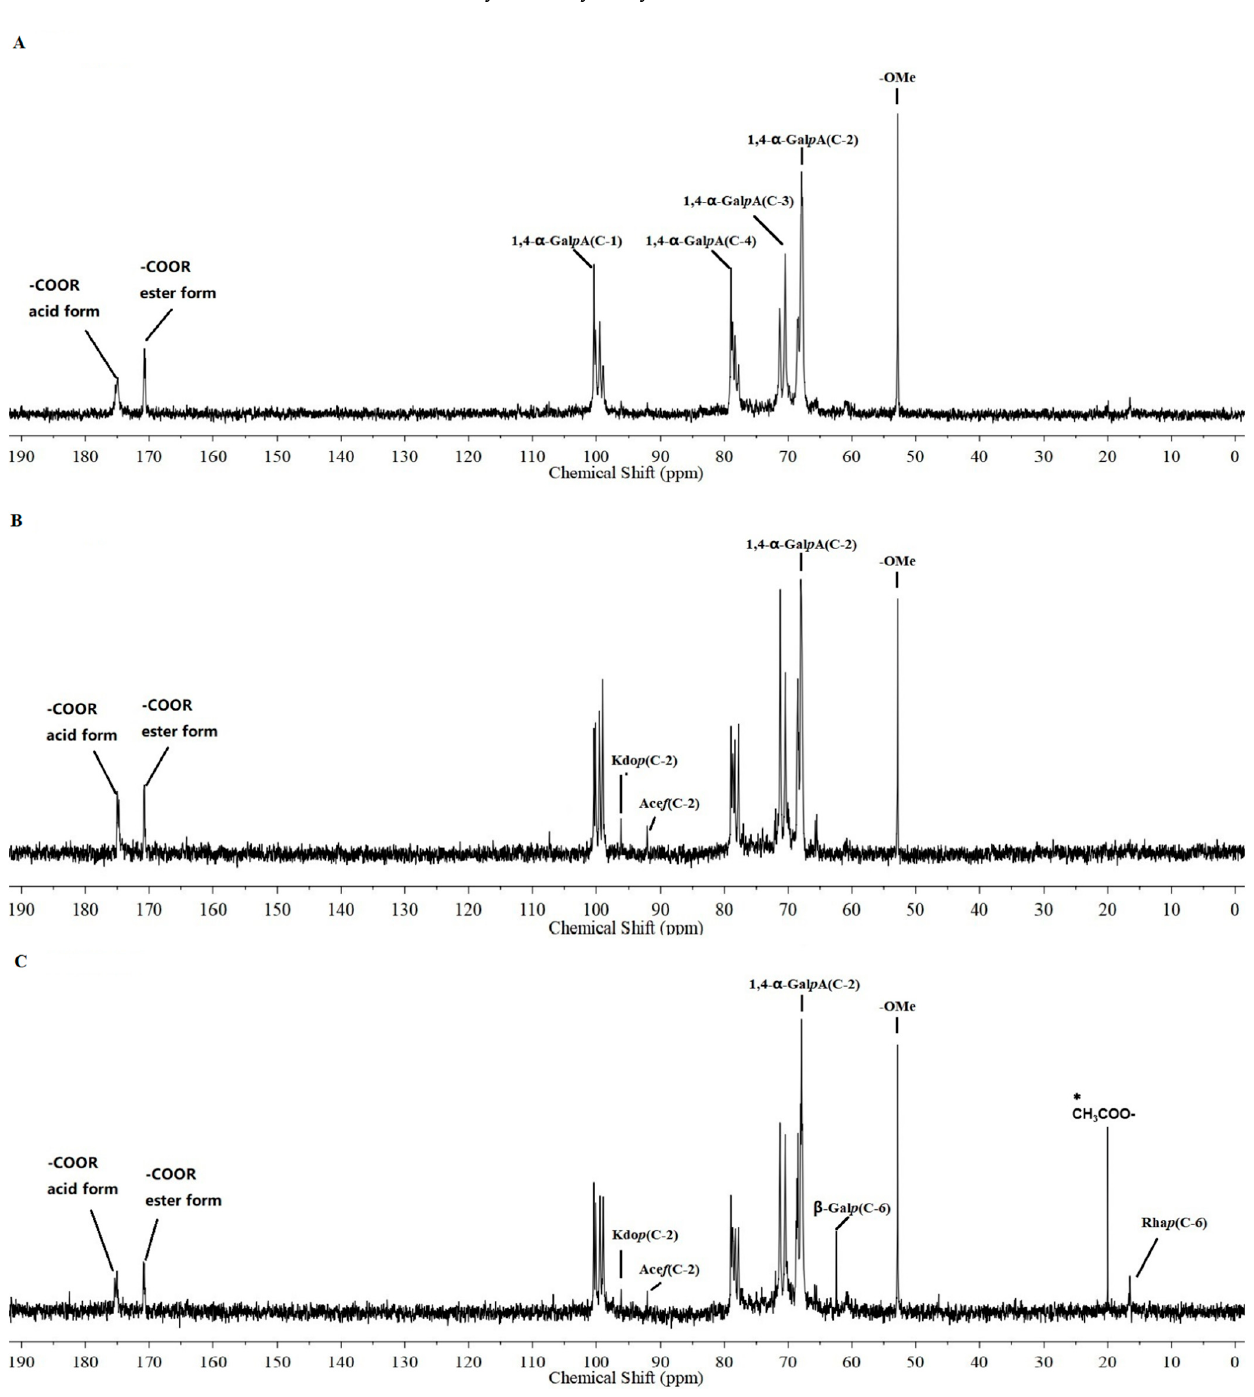
Figure 5. 13 C NMR spectra of ( A ) WACP(R)-A-c, ( B ) WACP(S)-A-c, and ( C )